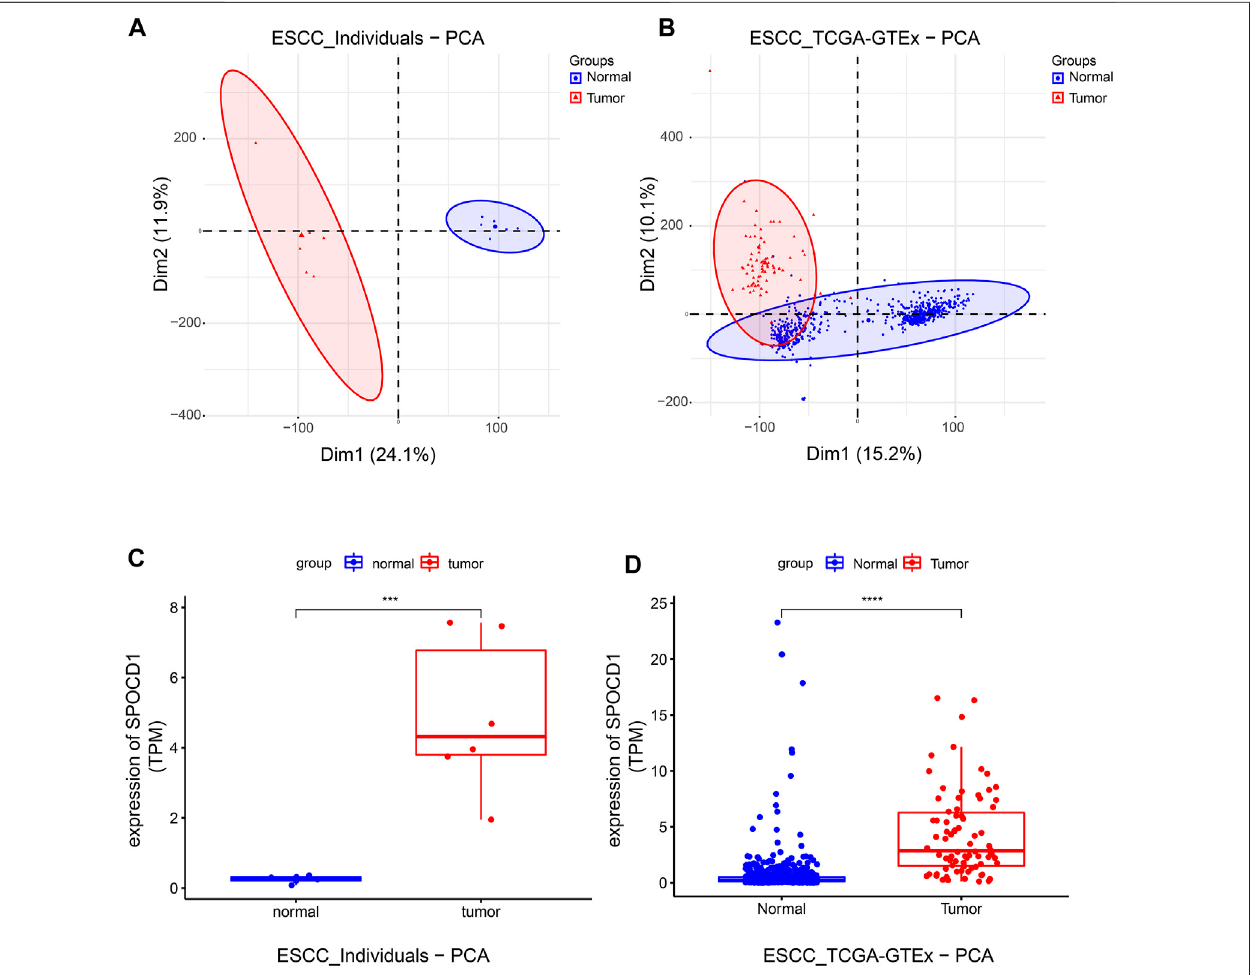
FIGURE 2 | The grouping of tumor and normal samples and the detection of SPOCD1 expression. (A) The results of PCA analysis of the sequencing data of our center samples; (B) The results of PCA analysis of the sequencing data of TCGA combined with GTEx dataset samples; (C) The sequencing data of our center showed that the expression of SPOCD1 in esophageal squamous cell carcinoma was signi fi cantly higher than that in the normal group; (D) The sequencing data of TCGA combined with GTEx data set showed that the expression of SPOCD1 in esophageal squamous cell carcinoma was signi fi cantly higher than that in the normal group. *** p < 0.001, **** p < 0.0001. SPOCD1, SPOC Domain Containing 1; ESCC, esophageal squamous cell carcinoma; TCGA, The Cancer Genome Atlas; PCA, principal component